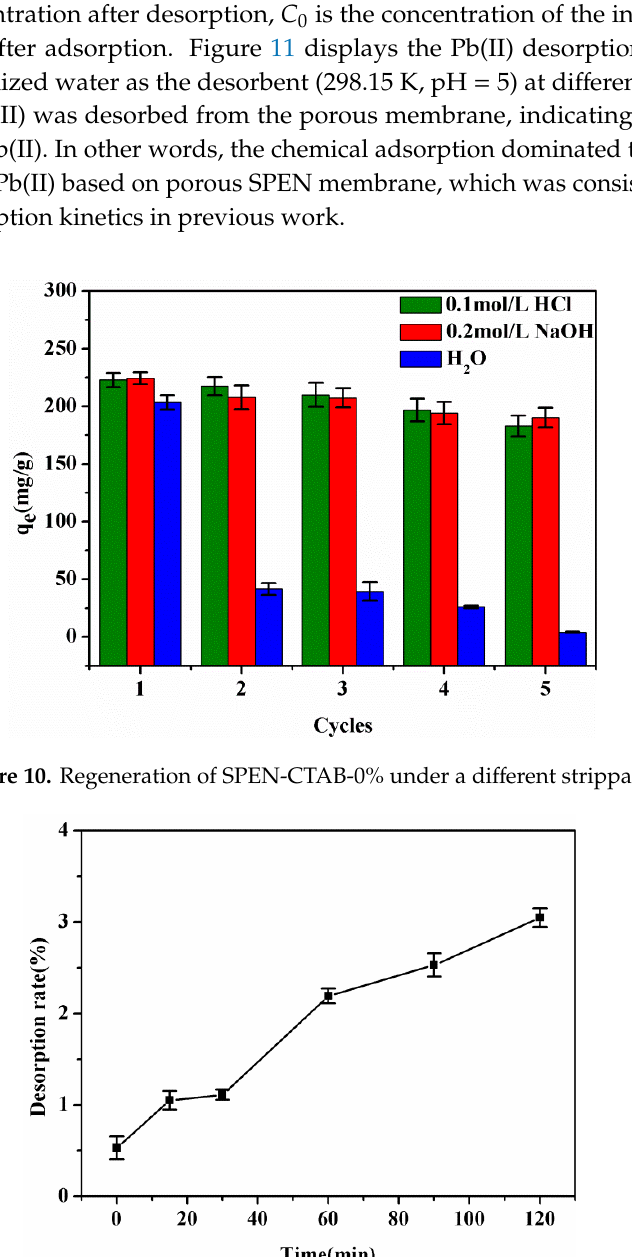
Figure 11. Desorption rate of SPEN-CTAB-0% at different times using water as a strippant.